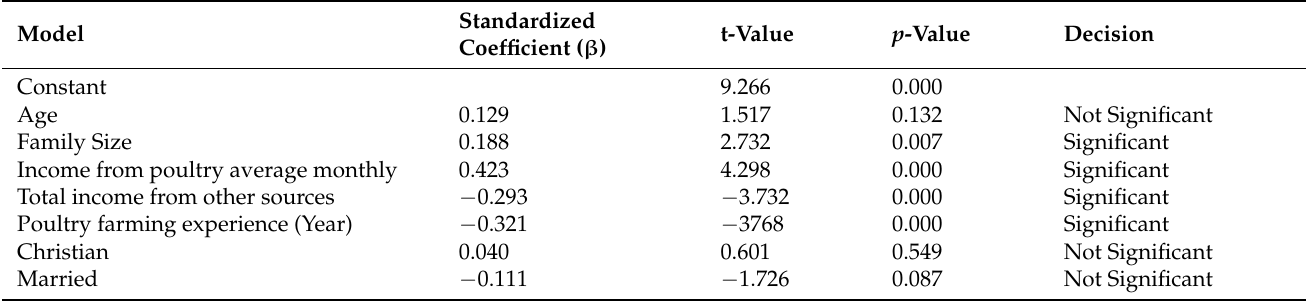
Table 5. Table determinants of acceptability of BSF among poultry